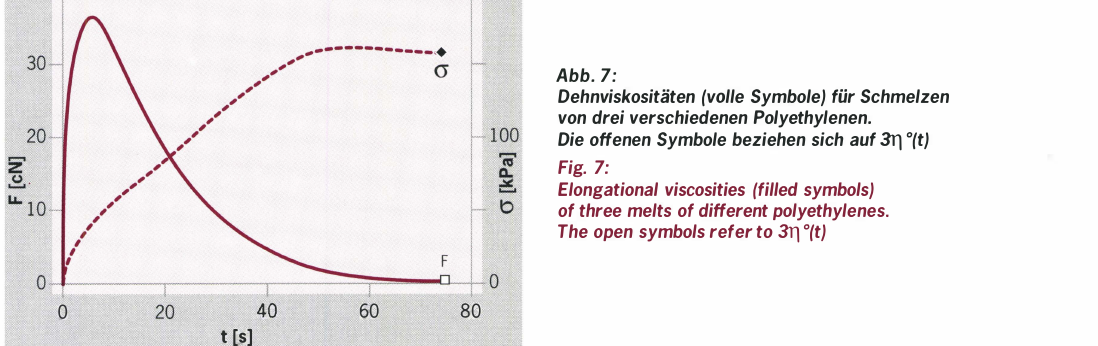
Fig. 7: Elongational viscosities (filled symbols) of three melts of different polyethylenes. The open symbols refer to 3J1